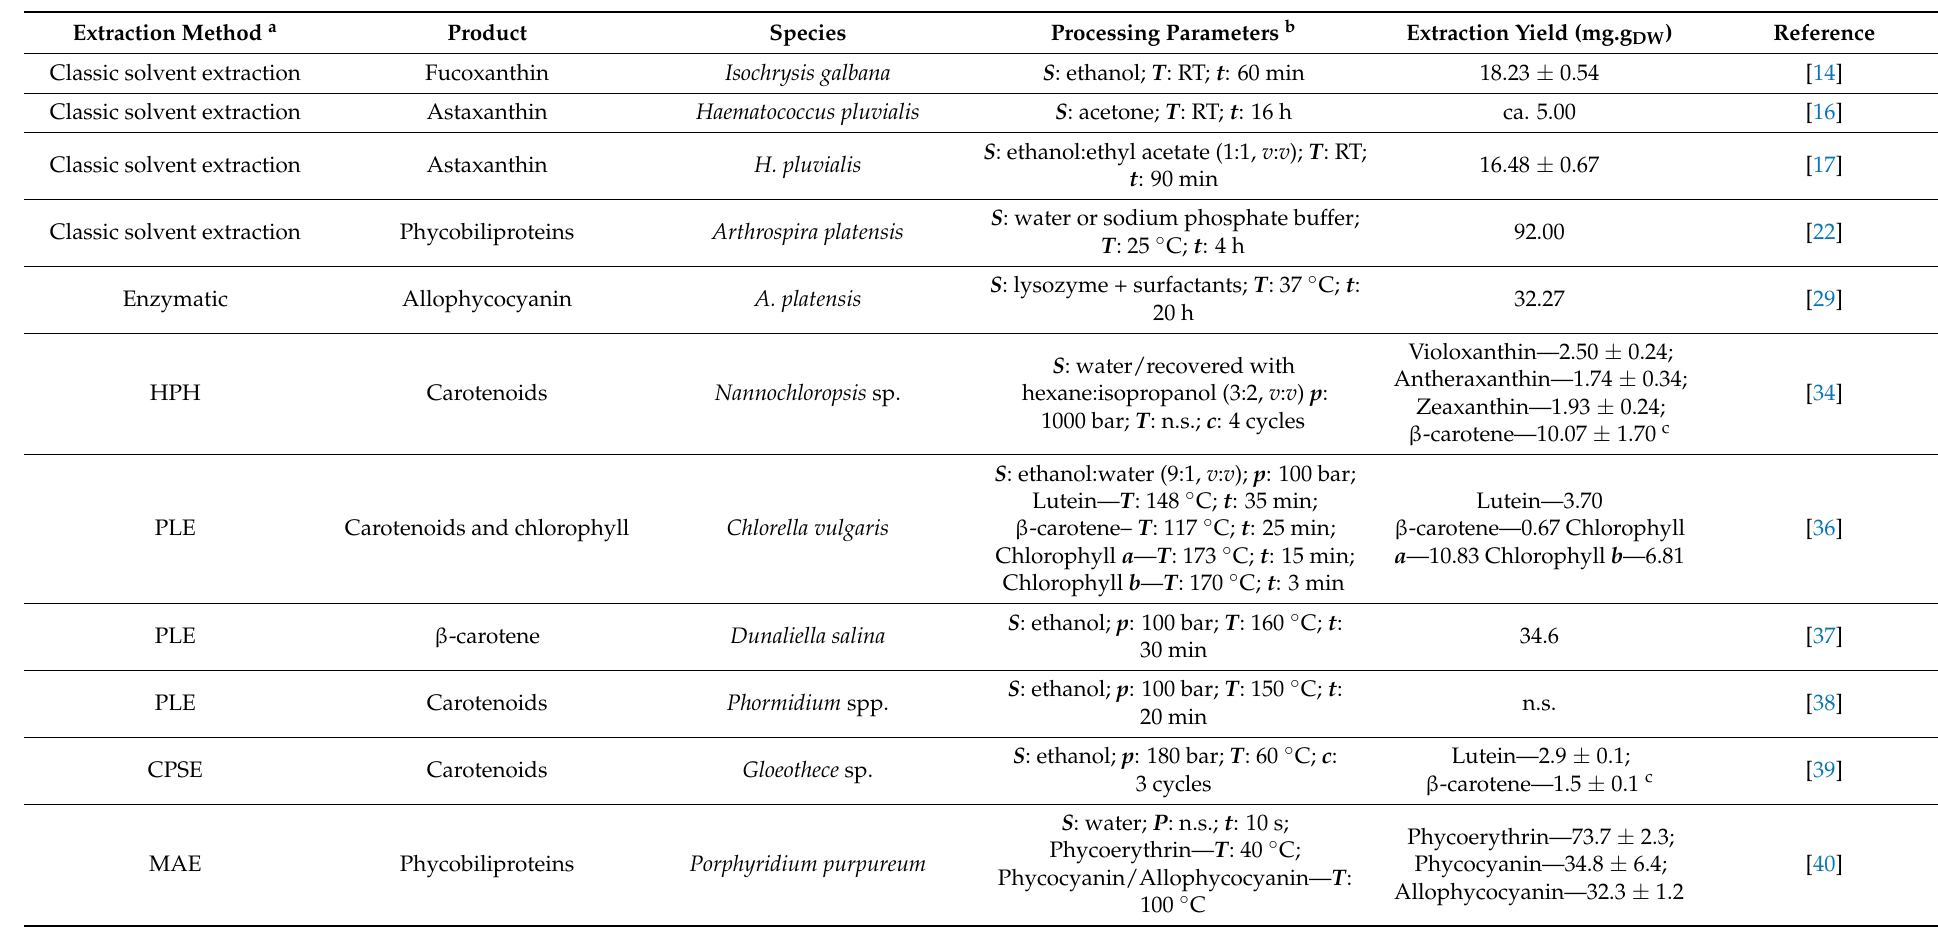
Table 1. Extraction parameters and yields of pigments from cyanobacteria and microalgae, using different extraction